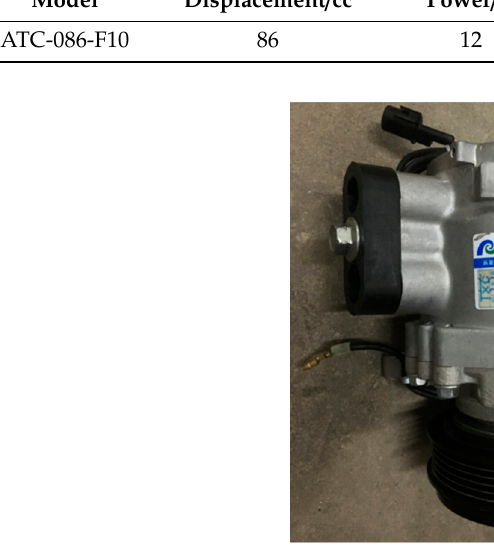
Figure 6. The Coriolis mass flowmeter.